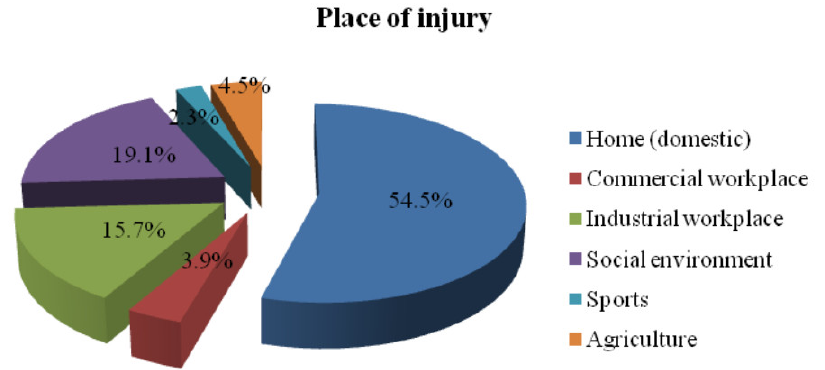
Figure 2. Showing place of injury for patients ( N =